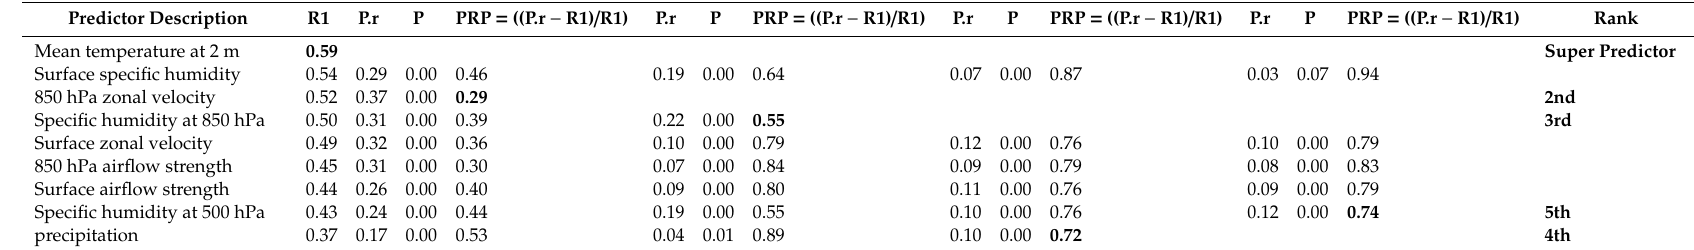
Table 2. Predictor selection for Kitgum